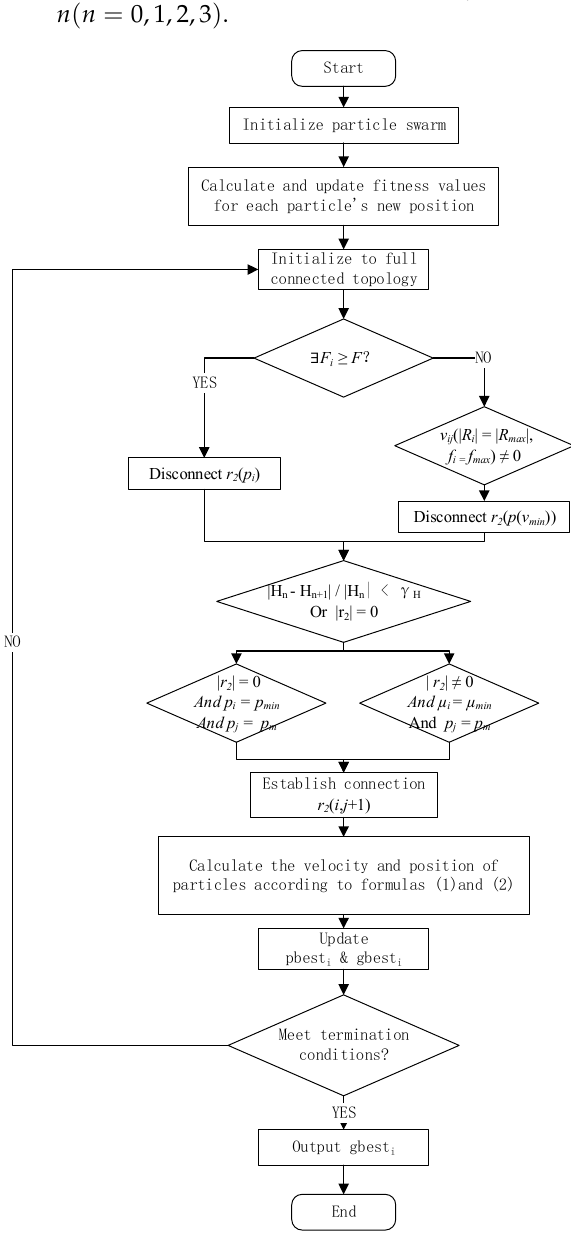
Figure 4. Topological evolution